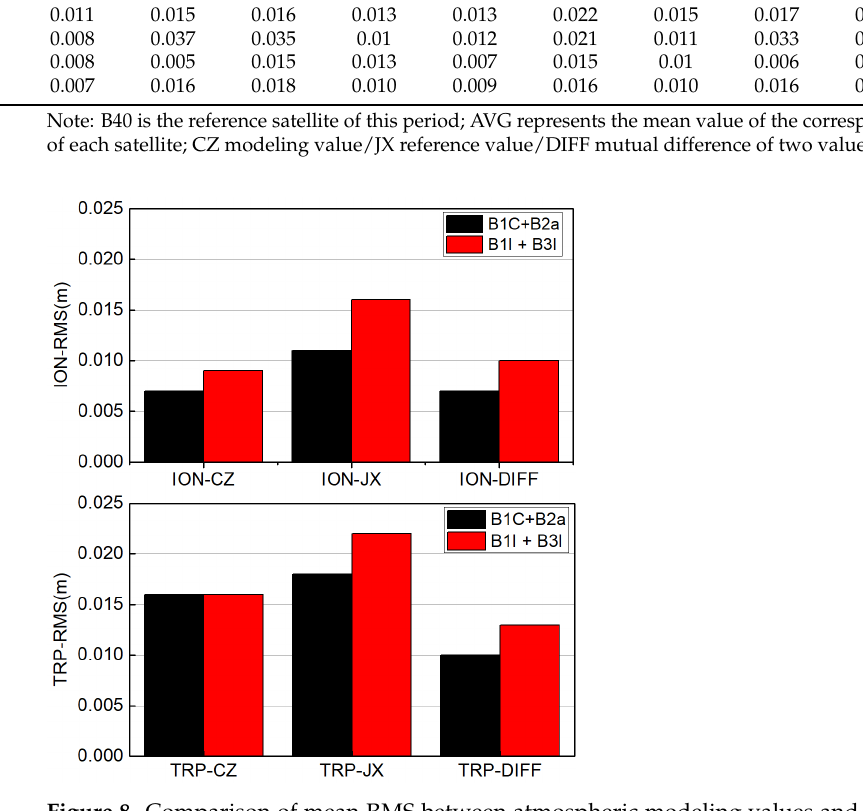
Figure 8. Comparison of mean RMS between atmospheric modeling values and reference values under different frequency signal combinations at Station SC17.